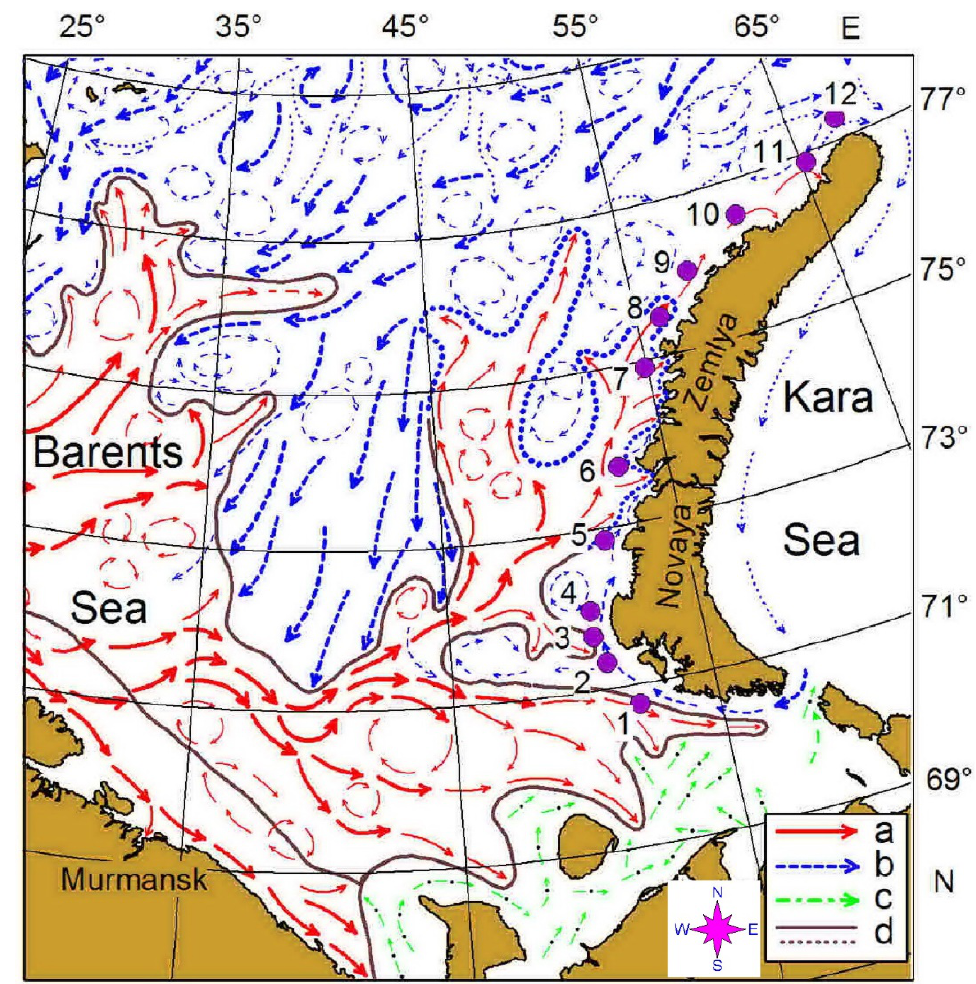
Figure 1. Location of the sampling area in the eastern Barents Sea in May 2016. Location of main currents and frontal zones according to [45]: a—warm currents; b—cold currents; c—coastal currents; d—boundary of the frontal zones.